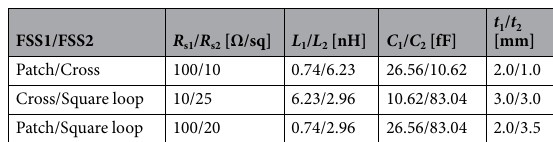
Table 4. Optimized design parameters for double-layered absorbers with different FSS1/FSS2 combinations depicting the widest